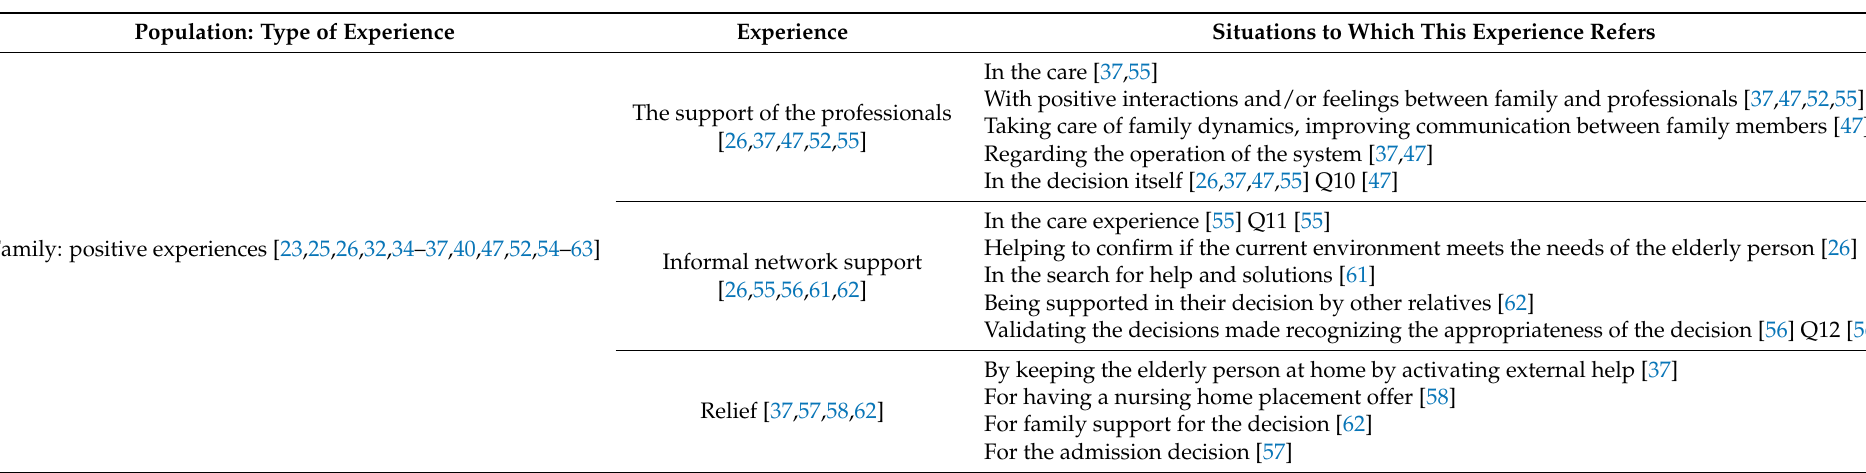
Table 3. Relevant positive experiences of family members a